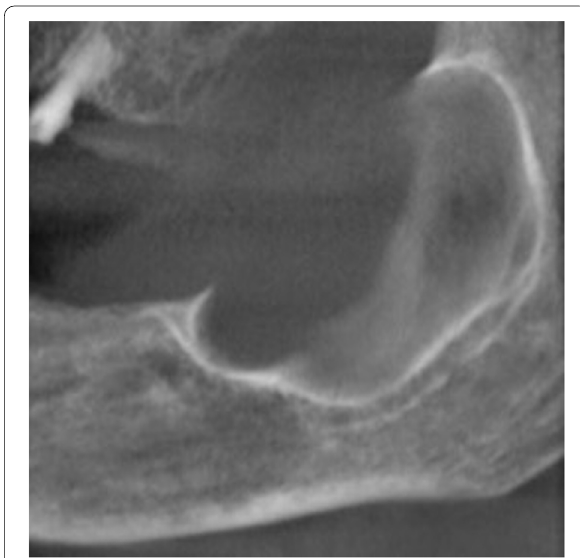
Fig. 2 Sagittal view: wide unilocular oval cystic lesion of the left retromolar trigone. The lesion measures 40 mm and shows a sclerotic margin. The anterosuperior cortex is resorbed. The mandibular canal is separated from the lesion by a thin bone